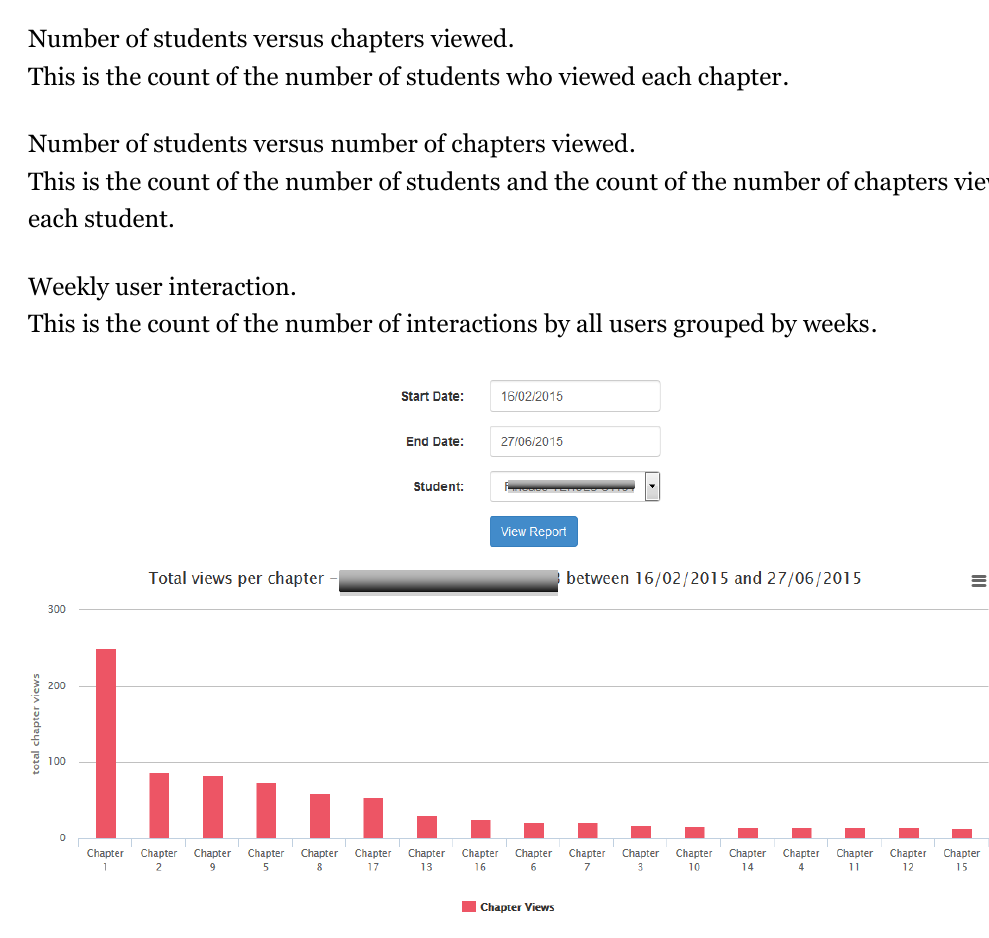
Figure 6. Snapshot of the learning analytics